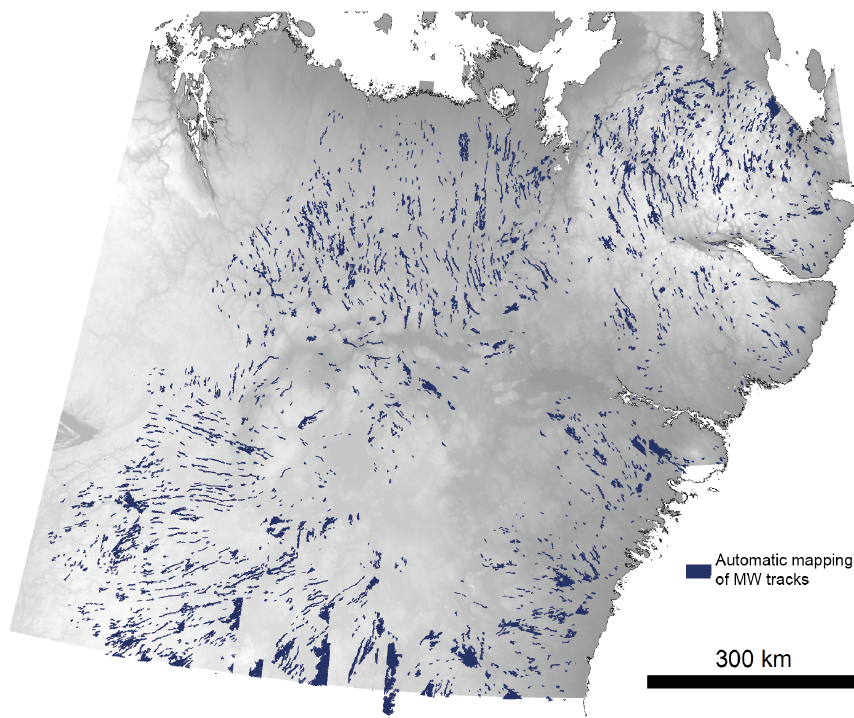
Figure A1. Automatic mapping output (cleaned up) for test site using code associated with Lewington et al. (2019).